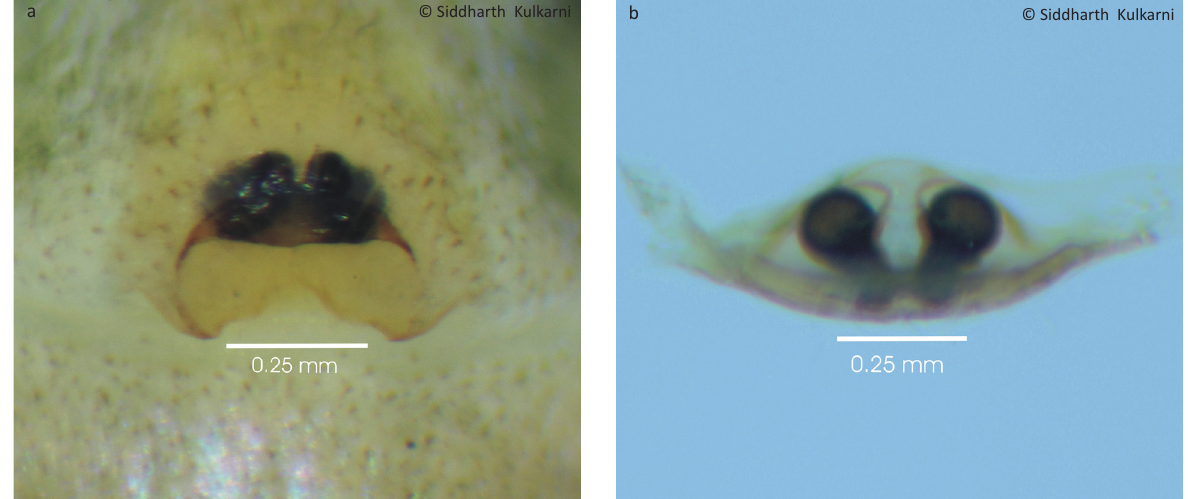
3. Siler semiglaucus. a - female epigynum, ventral view; b - female epigynum, dorsal